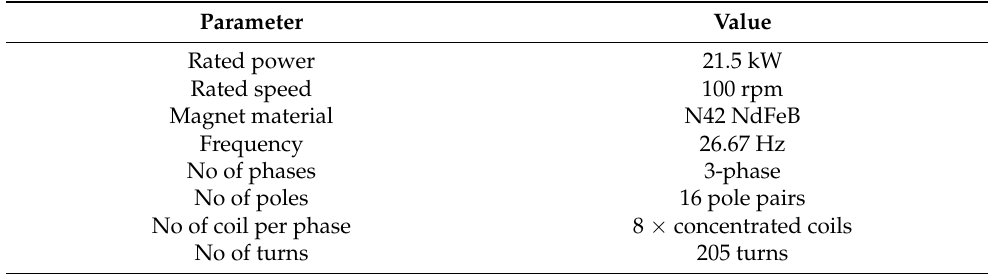
Table 1. Parameters of the C-Gen generator under